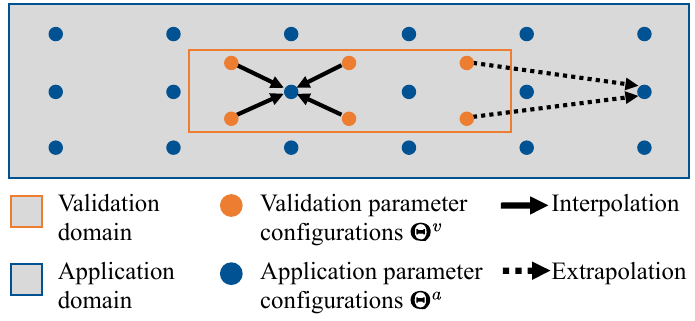
Figure 3. Predicting the future reliability of an application domain by inter- and extrapolation from a validation domain based on Riedmaier et al.